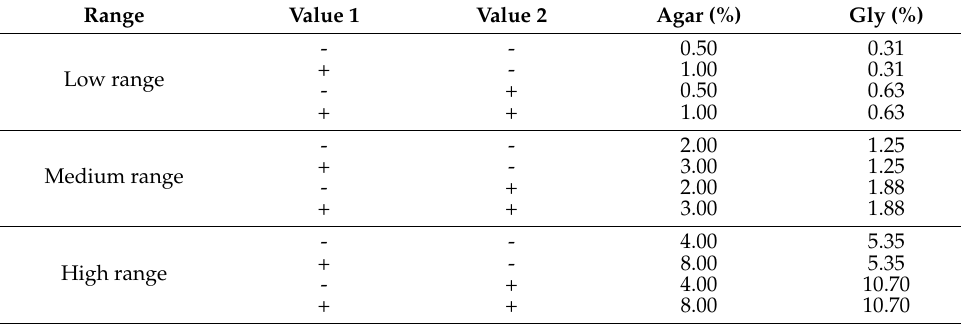
Table 1. Input data for Design of Experiments (DoE).